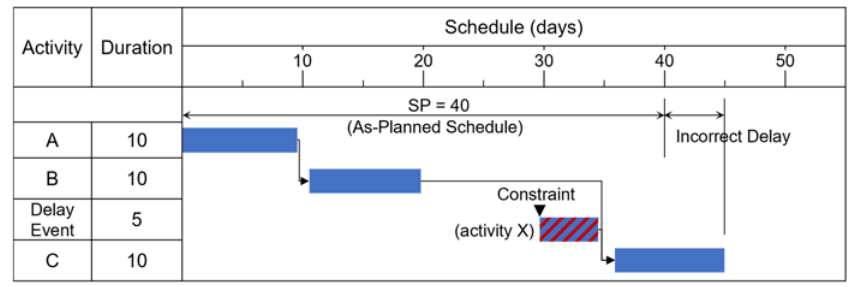
Figure 6. Overestimation of a delayed impact.